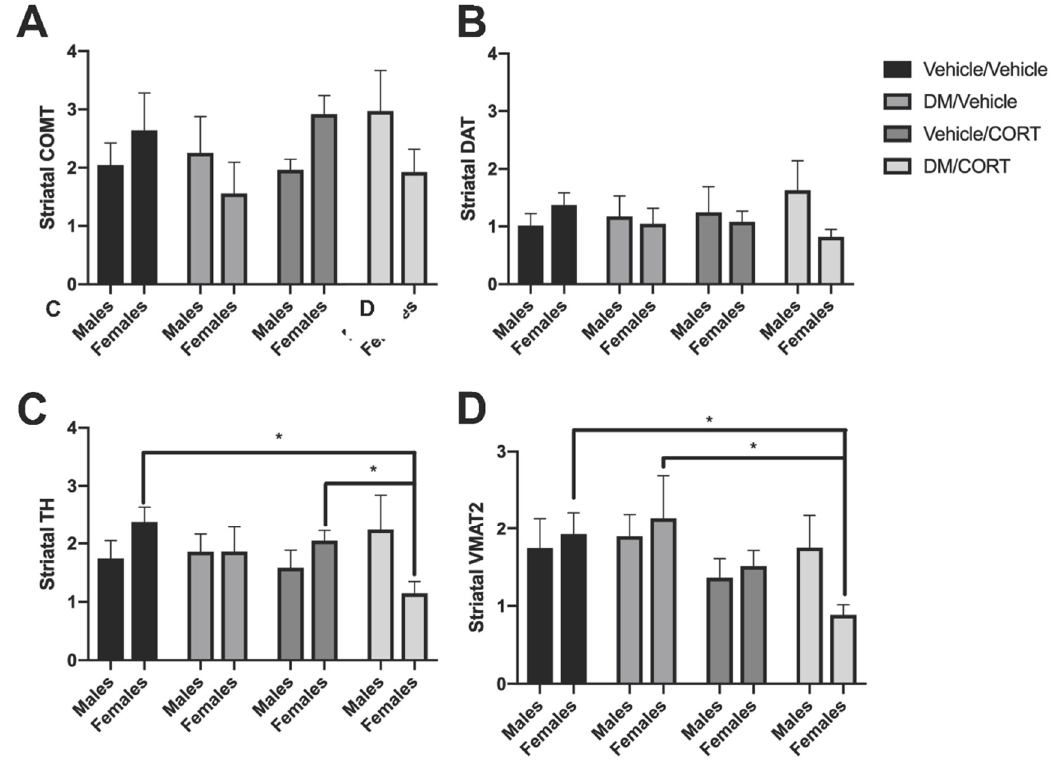
Figure 4. Striatal TH and VMAT2 expression was significantly decreased in female o ff spring exposed to deltamethrin (DM) and corticosterone (CORT). COMT ( A ), DAT ( B ), TH ( C ), and VMAT2 ( D ) protein expression in the striatum was assessed in male and female o ff spring exposed to one of four treatment groups. Striata were collected at 8–10 weeks of age. Protein expression is expressed as adjusted units (AU) assessed via densitometry analysis and normalized to actin. Exposure group di ff erences were evaluated via one-way ANOVA with Tukey’s post-hoc test and stratified by sex. * p < 0.05, N = 5–7, and error bars represent SEM.